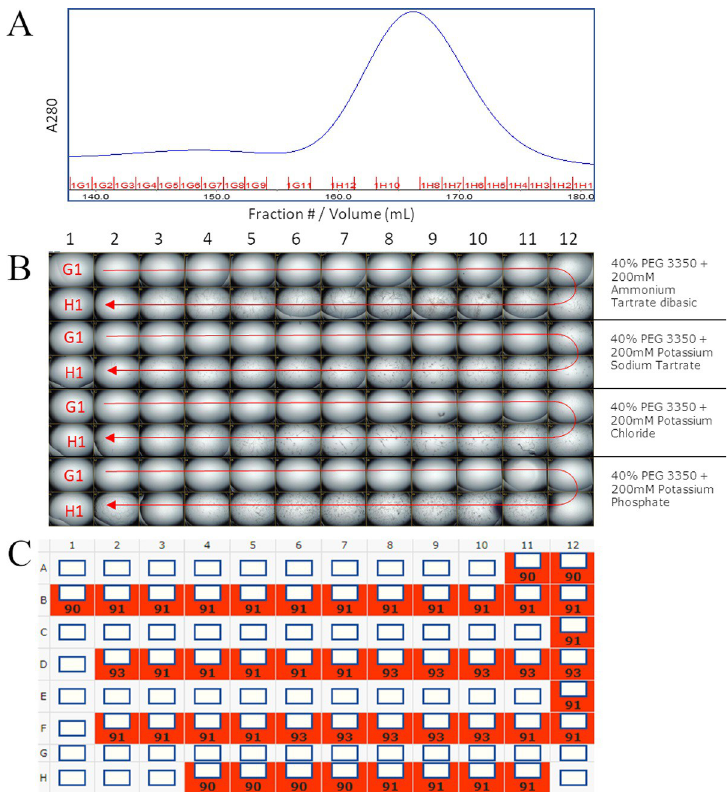
Fig 6. Crystal structures of Crystal Kappa variants in complexes. (A) Dupilumab Fab (HC in green and LC in cyan) complexed with human IL4R extracellular domain (in magenta and glycosylation in yellow sticks, PDB: 6WGL), (B) human IL17 dimer (magenta and pink) complexed with Secukinumab Fabs (HCs in green and LCs in cyan, PDB: 6WIR).